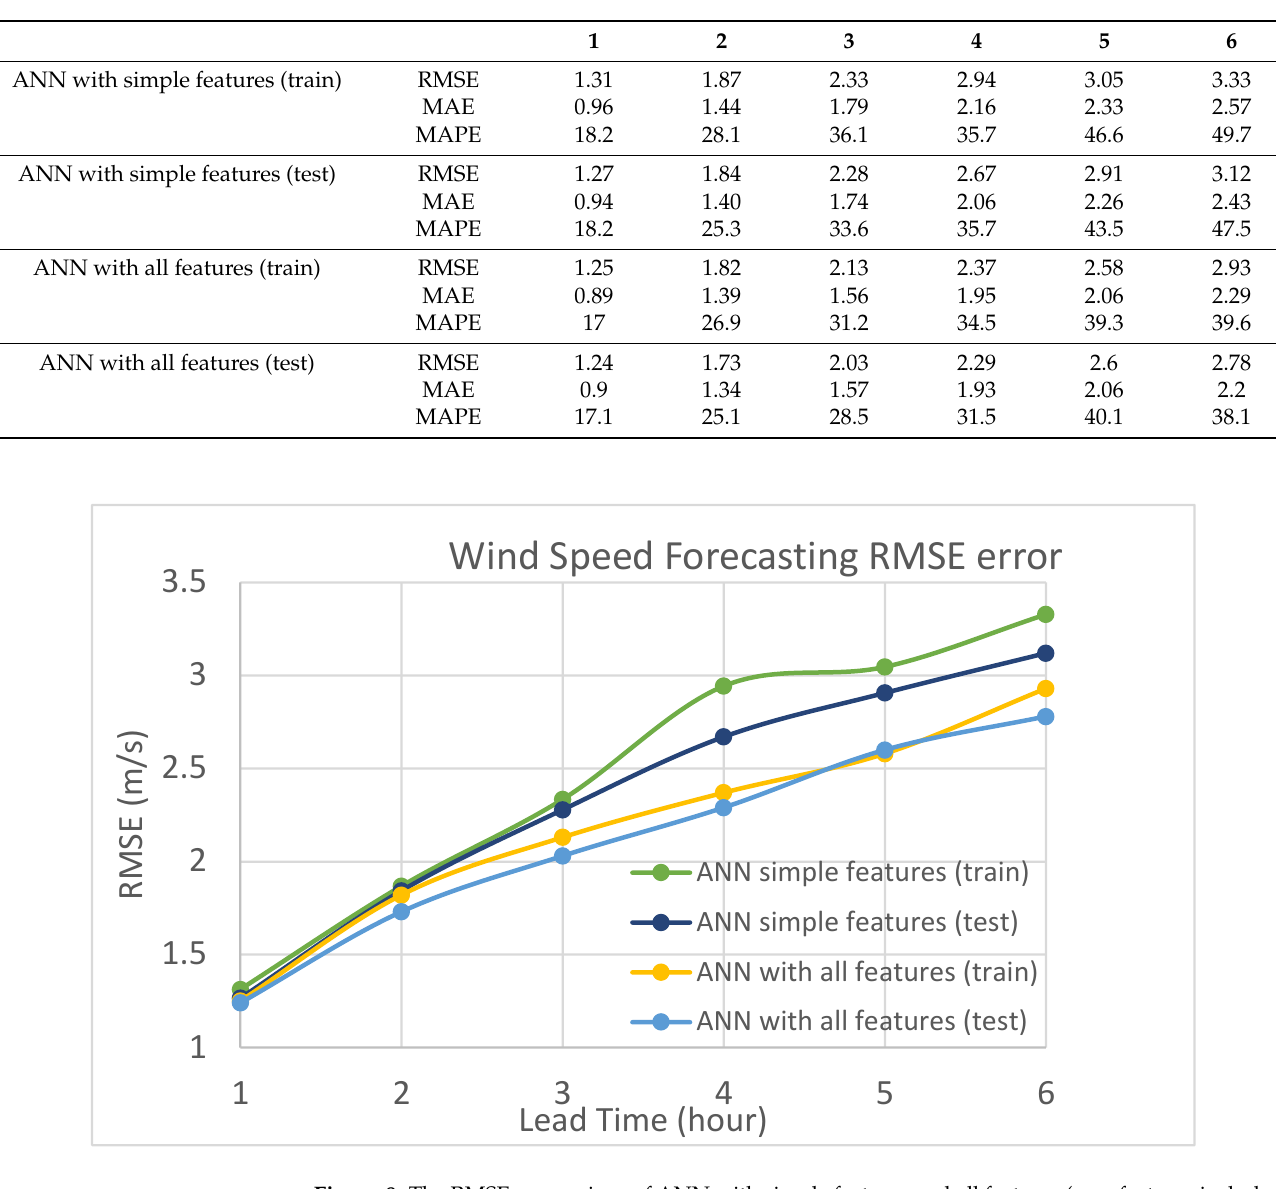
Figure 8. The RMSE comparison of ANN with simple features and all features (new features included).